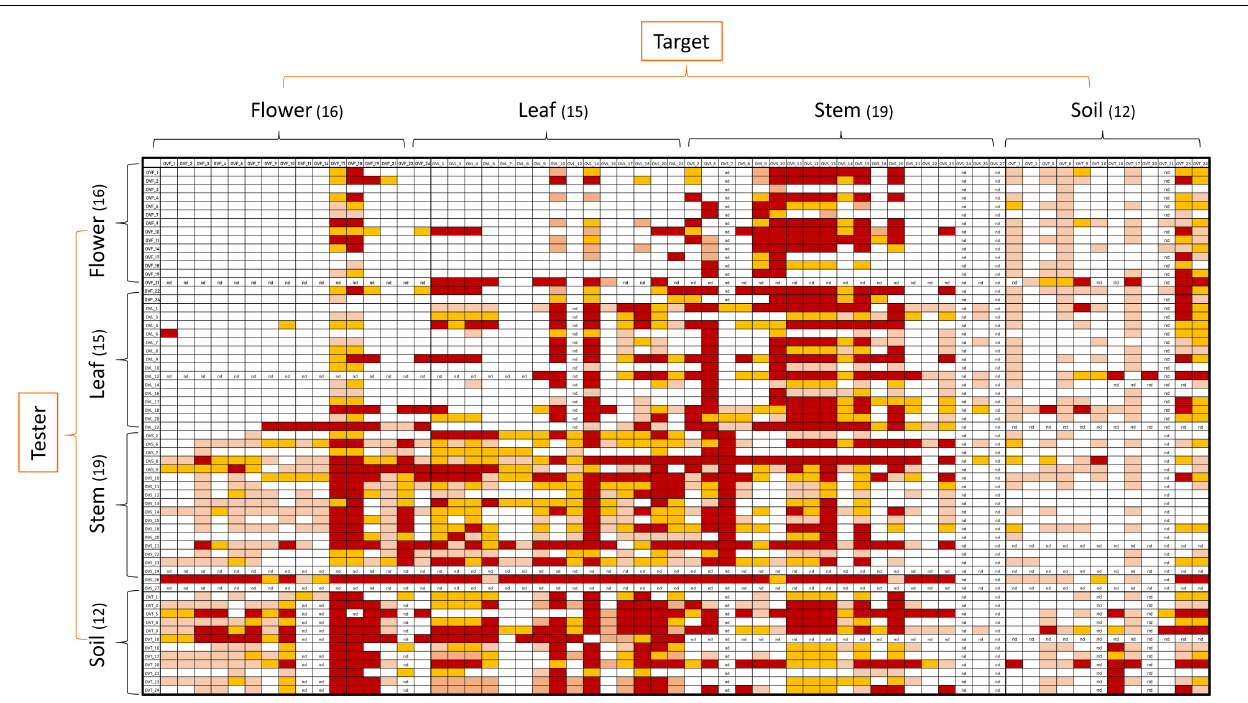
FIGURE 4 | Heatmap showing the antagonistic interactions existing between endophytic (flower, leaf, stem) and soil bacteria isolated from the medicinal plant O. vulgare . Each strain was tested either as tester or target strain versus all the other ones. The inhibition values reflect three different inhibition levels observed during the cross-streak experiments, that is: complete (3, red), strong (2, orange), weak (1, salmon), and absence (0, white) of inhibition. Nd (not detected) refers to results that were not obtained.